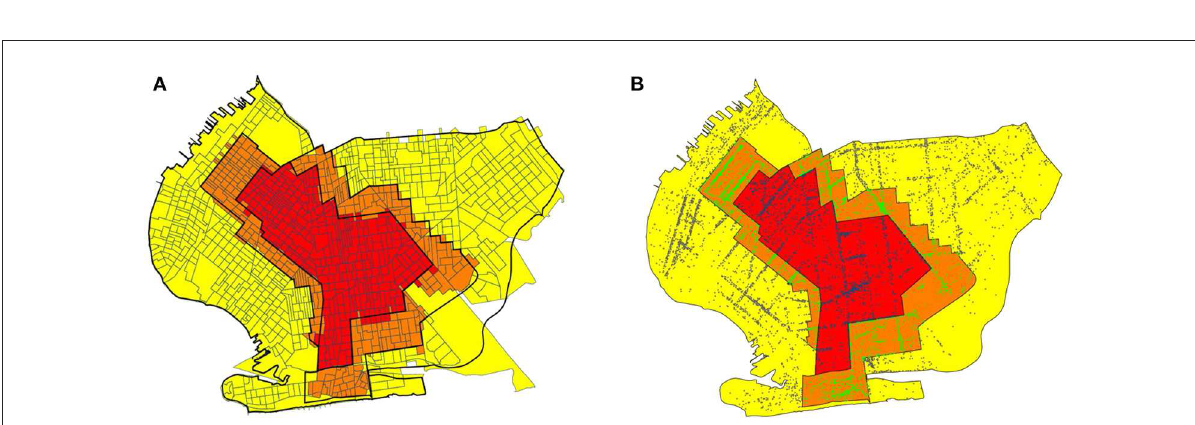
FIGURE3 (A) Boundaries of the original October 9 zones overlaid on map of census block groups (CBGs). In our calculations of within- and between-zone device movements, we assigned each CBG to the zone containing its geographic centroid. (B) Boundaries of the original October 9 zones overlaid on map of Safegraph points of interest (POIs) (38). Each point corresponds to a POI. Points have different colors depending on the regulatory zone in which they were located. For base map of New York City census block groups, see Ref. (39).